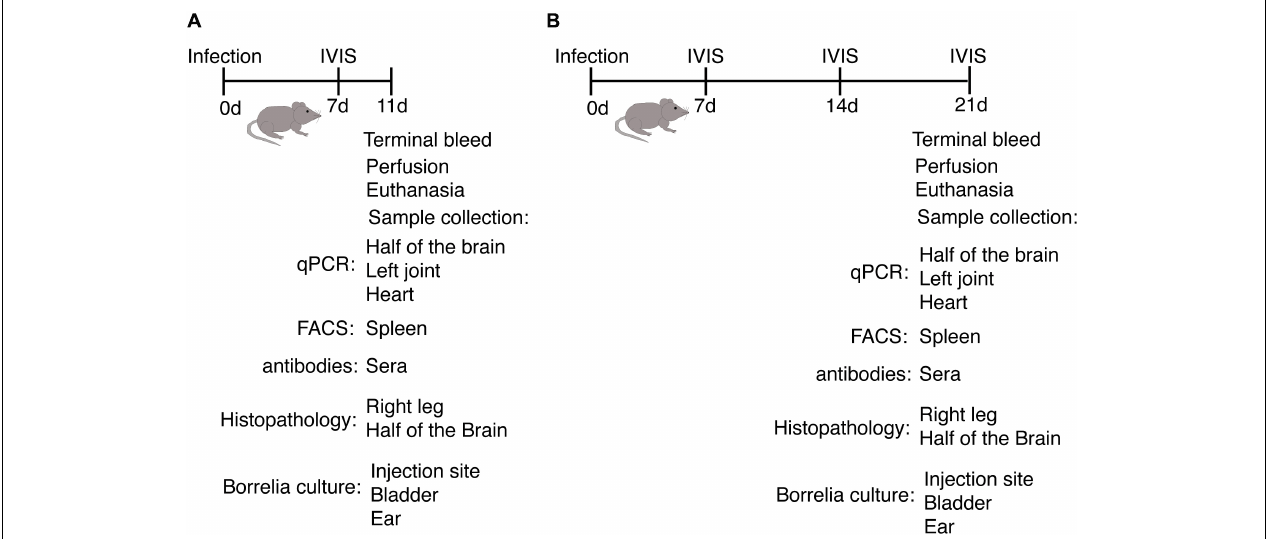
FIGURE 2 | Outline of animal experiments to determine host response and disease manifestations after infection with B. burgdorferi N40 strain and/or B. microti (Bm) . (A) Experimental plan and samples analyses at the acute phase (11th day p.i.) of infection of C3H/HeJ female mice. (B) Evaluation of the impact of infection on the host and pathogens when the parasitemia becomes undetectable microscopically (21st day